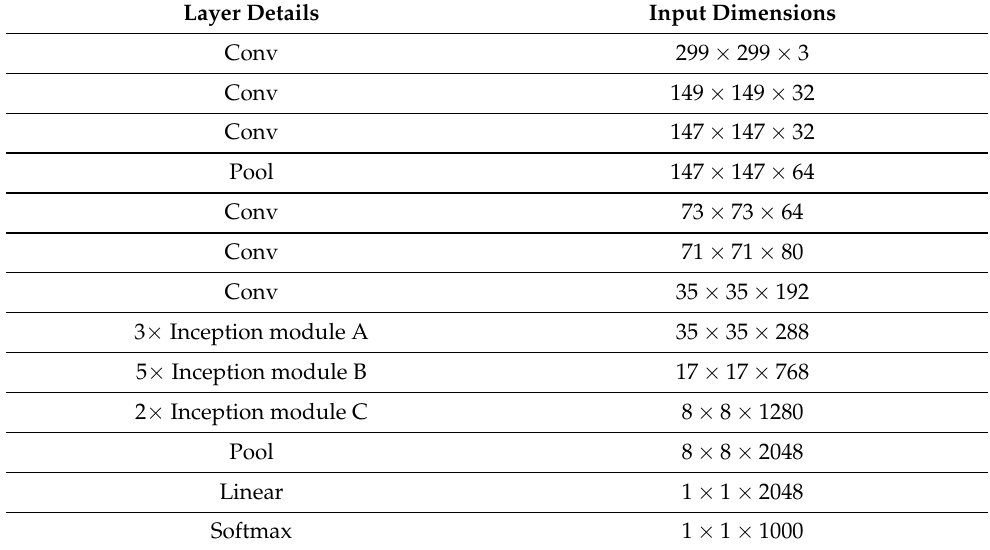
Table 3. Inception v2